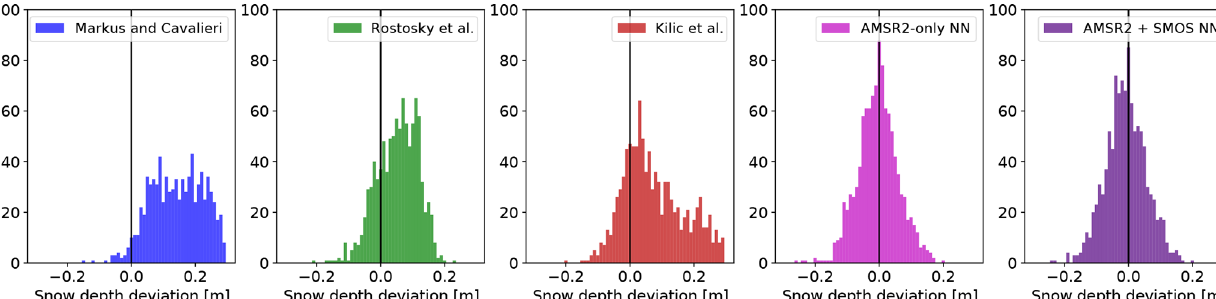
Figure 6. Deviation from OIB (estimated snow depth using different algorithms minus OIB-measured snow depth) for all OIB data. The vertical black line indicates a perfect match between OIB and the algorithm, the left half corresponds to an underestimation and the right half to an overestimation of snow depth compared to the OIB